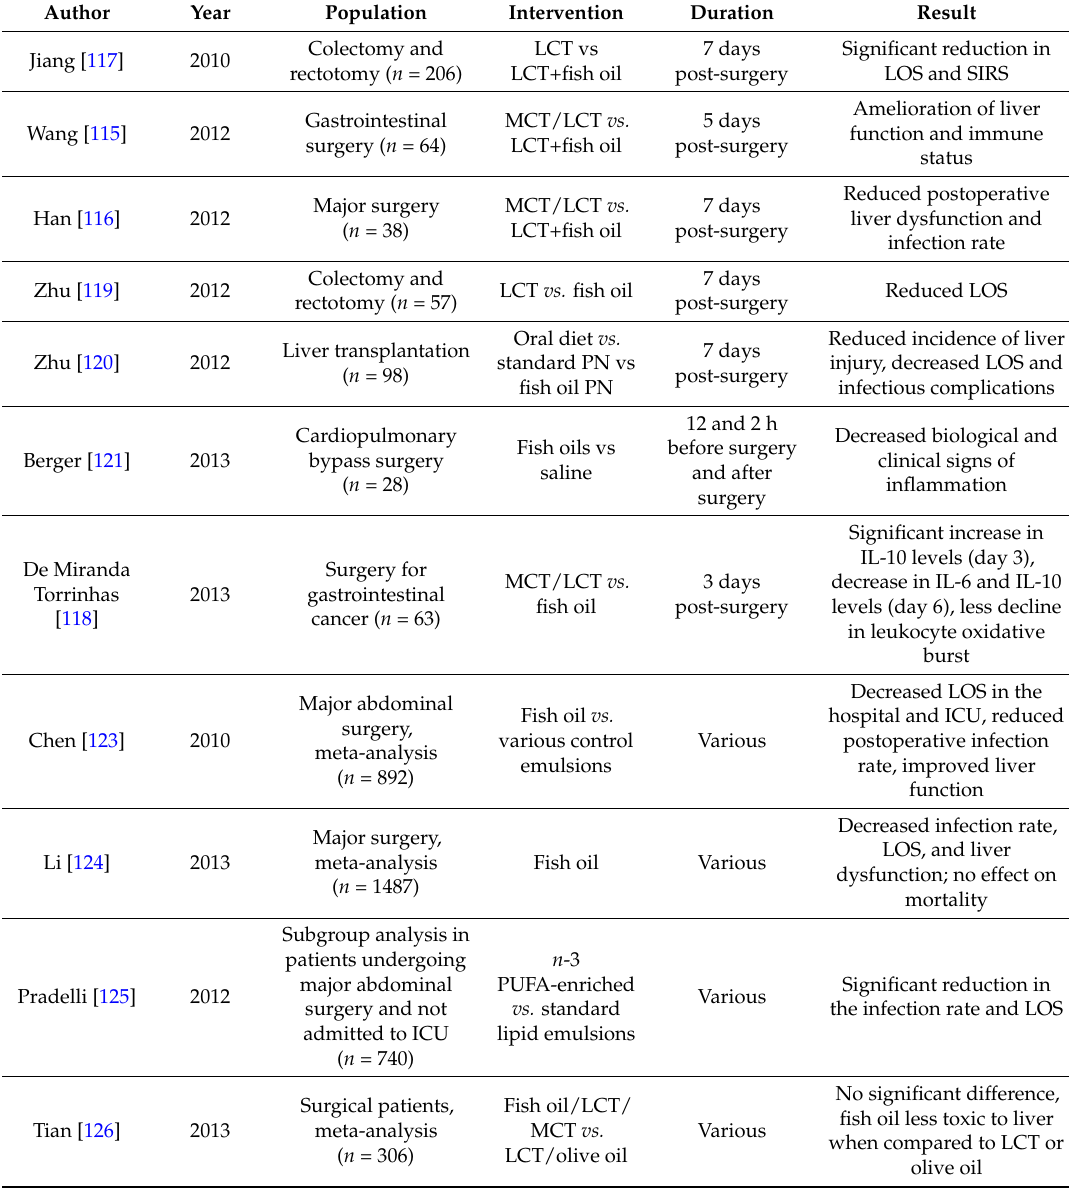
Table 1. Latest studies/meta-analyses evaluating the benefits of n -3 PUFA (polyunsaturated fatty acids) in parenteral nutrition in surgical populations